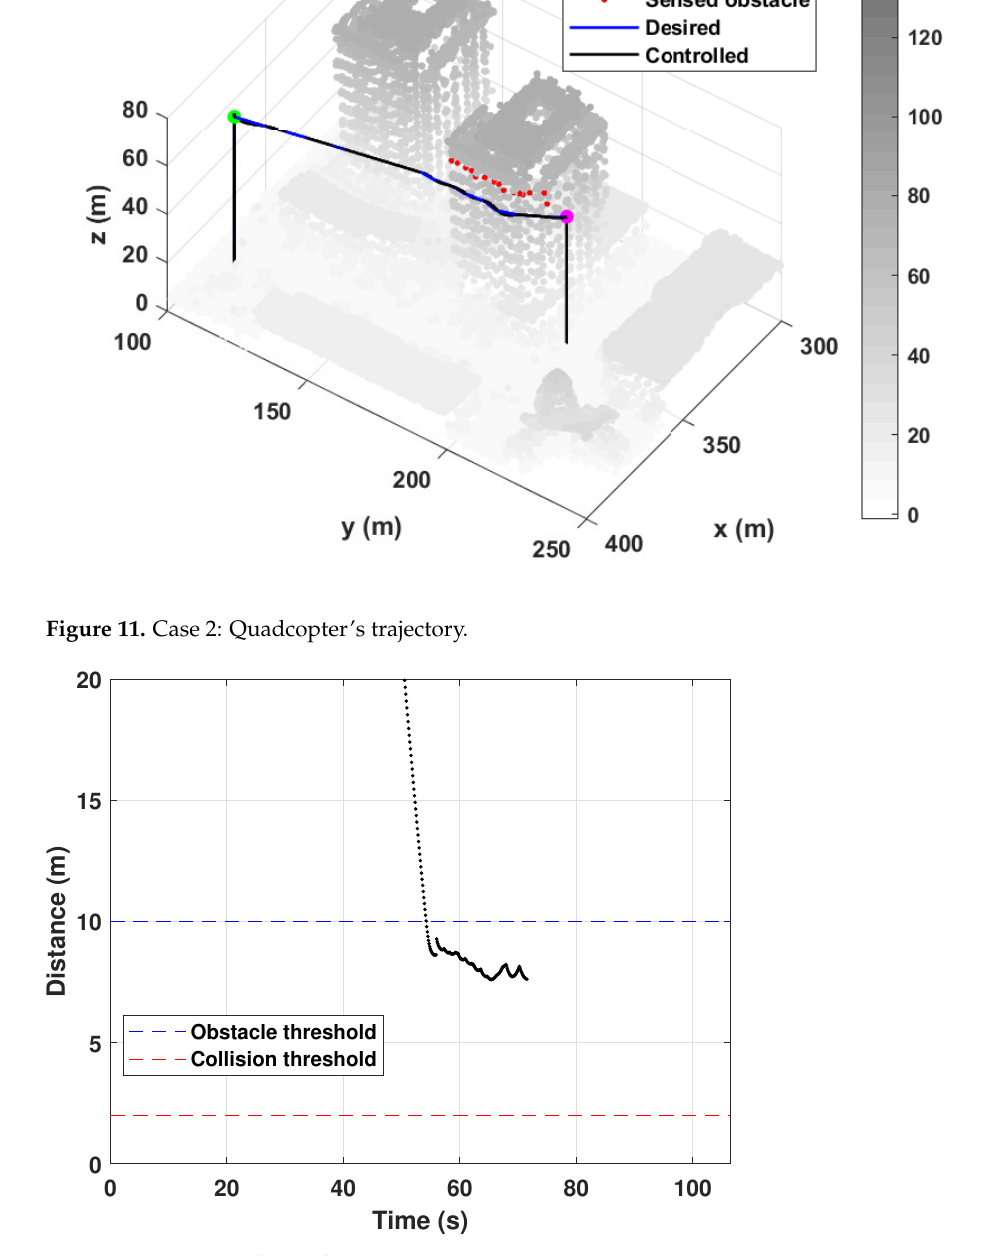
Figure 12. Case 2: Relative